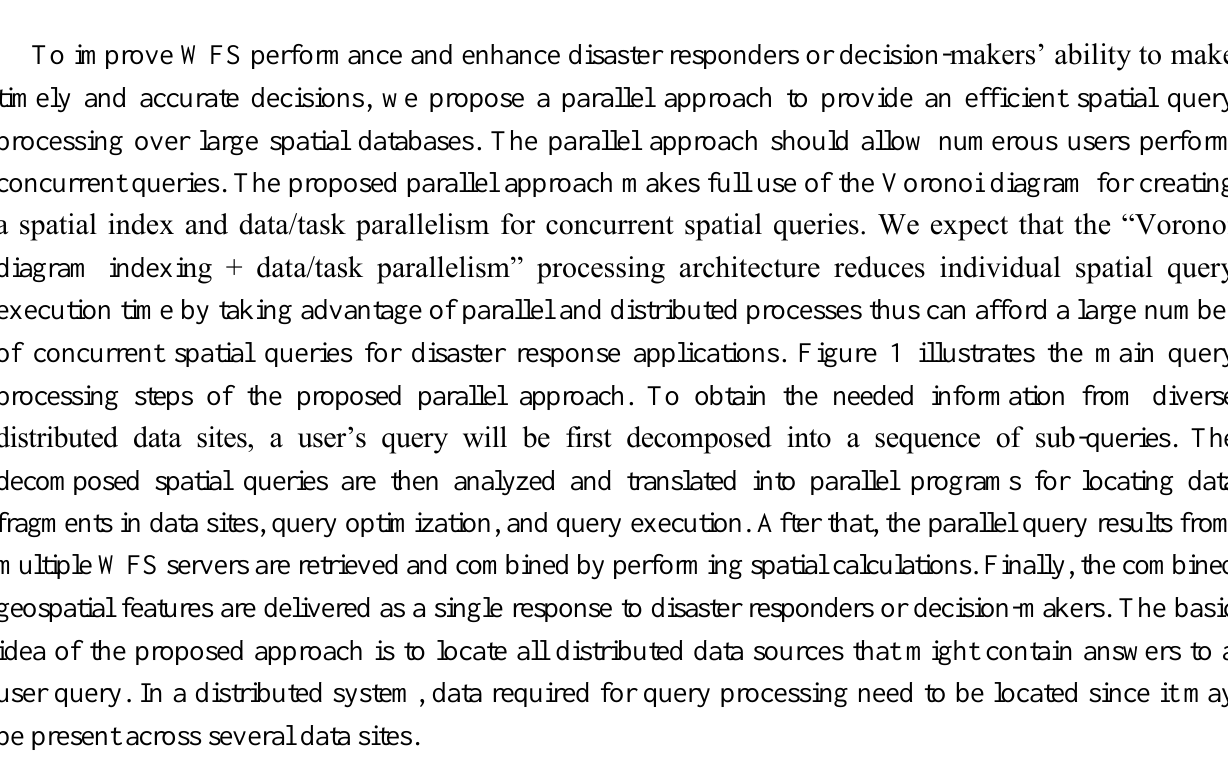
Figure 1. The main query processing steps of the proposed parallel